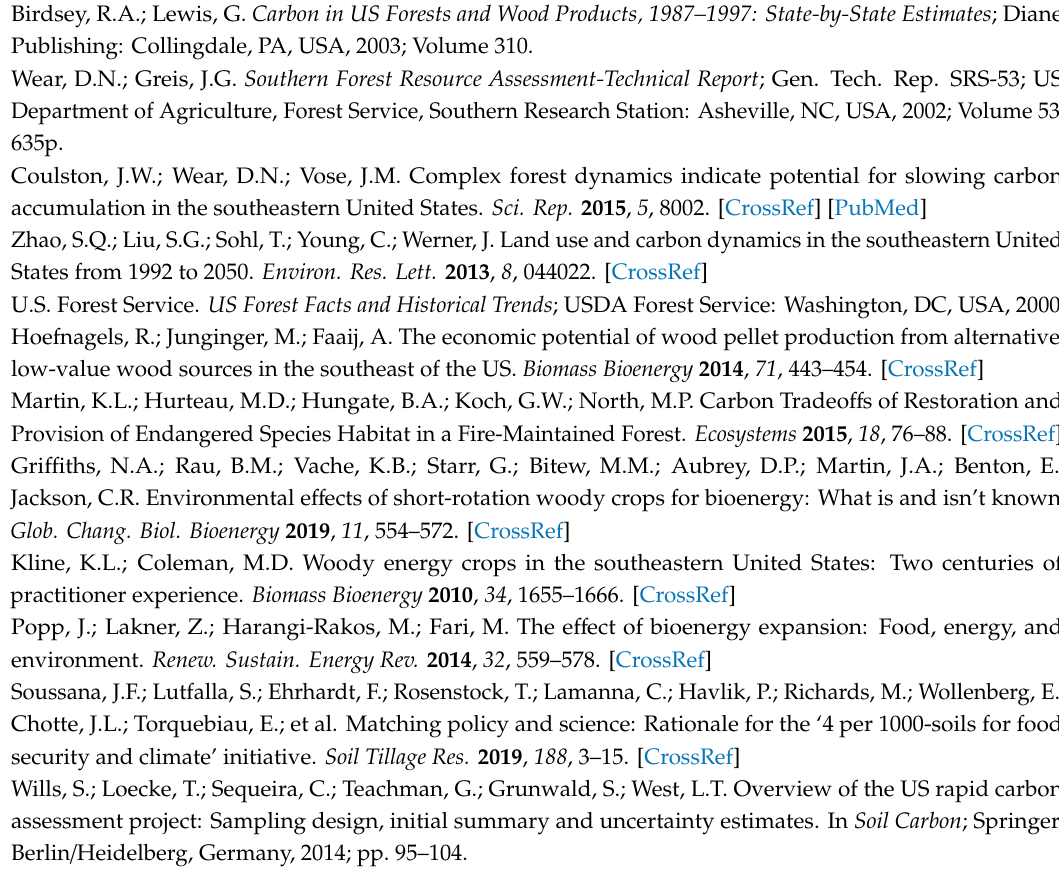
Table S1: Crosswalk between source and values of understory dead and live biomass for combined woodland class areas in 1951, including non-stocked areas. Table S2: Crosswalk between woodland classification in 1951 or forest groups in 2001 for applying equations to convert growing stock volume to aboveground live and dead tree biomass. Equation names refer to ownership and vegetation names for the SE Region. Table S3: Relationship between aboveground biomass taxa equations and species based on species assignments and numerical codes for